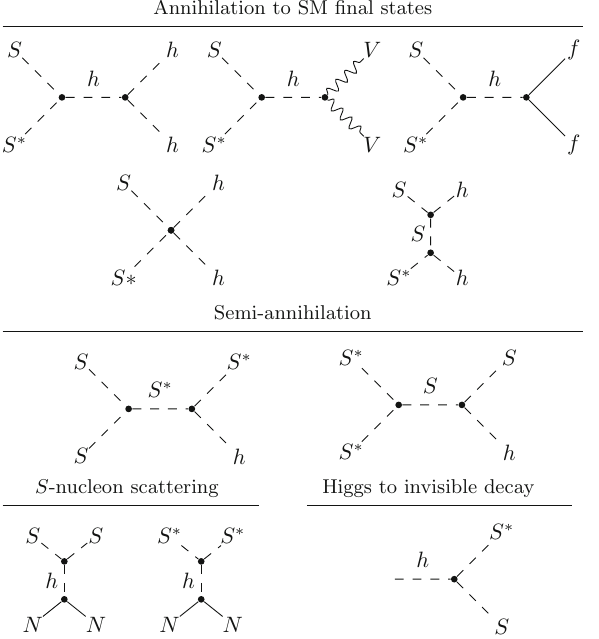
Here H is the Hubble rate, (cid:11) σv rel (cid:12) is the thermal average of the relative velocity of DM particles times their